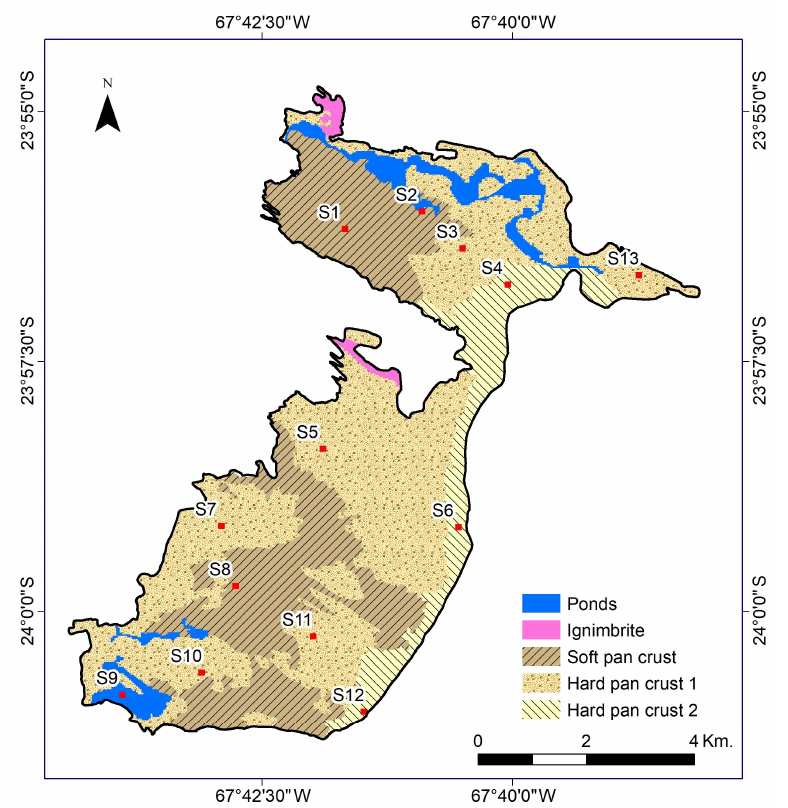
Figure 3. Distribution of the salt pan crusts modified from a technical report together with Centro de Informaci ó n de Recursos Naturales [4] and the corresponding author. The map is an original contribution of this paper. Red boxes indicate regions of